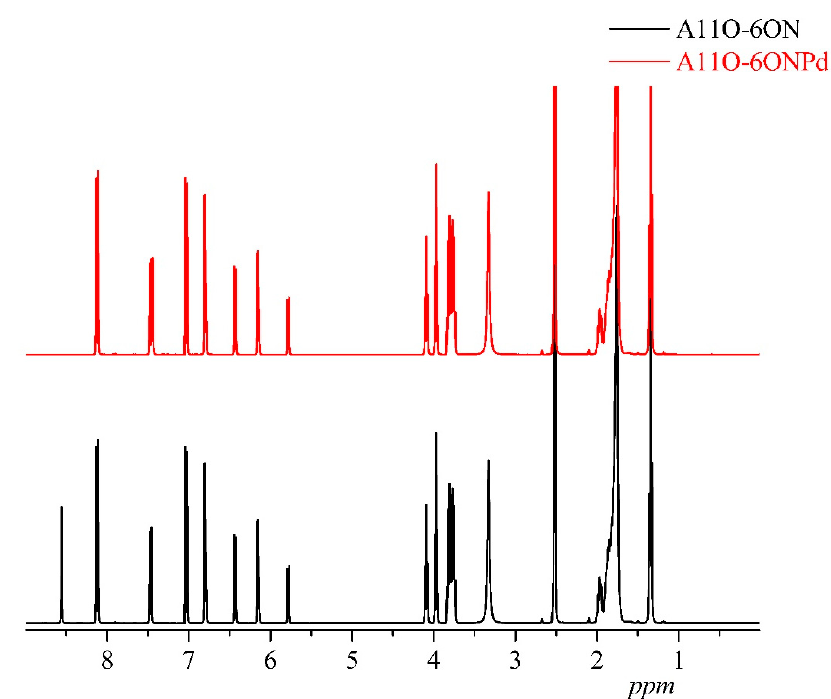
Figure 2. 1 H NMR curves of A11O − 6ON (red) and A11O − 6ONPd (black) . Elemental analysis, metal content and NMR (Figures S4 and S5) are consistent with the assigned formula for all synthetized compounds.